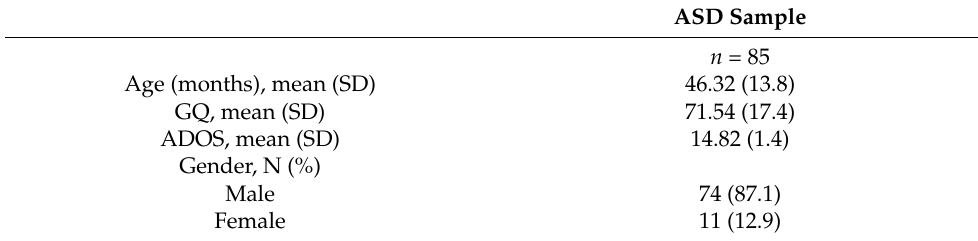
Table 1. Population